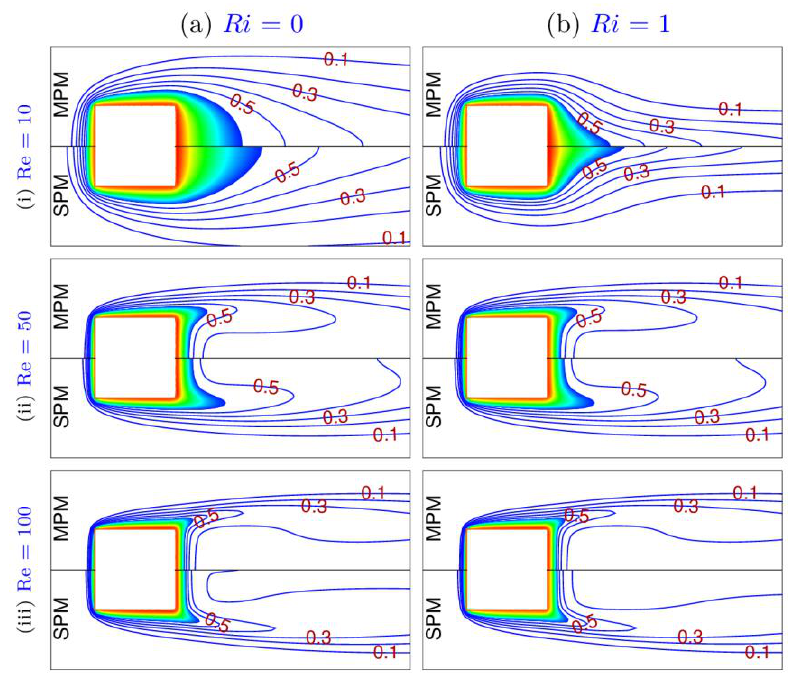
Figure 12. Comparison of isotherms on the basis of single-phase and multi-phase modelling approach at different values of Re and Ri at φ = 5% : ( a ) Ri = 0, and ( b ) Ri = 1.